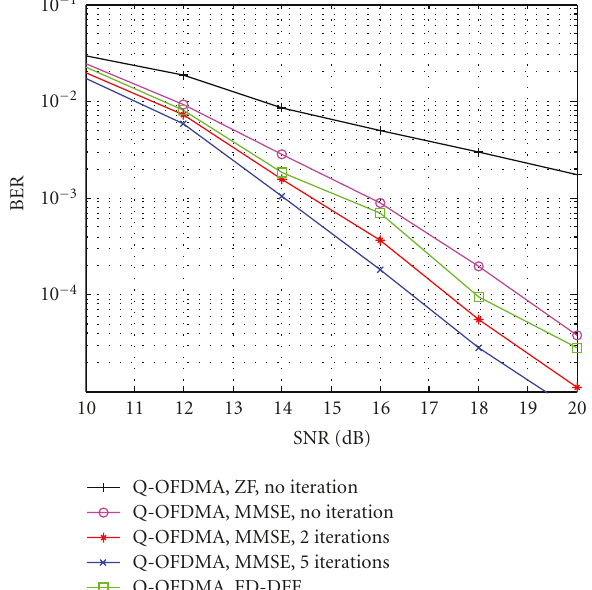
Figure 7: BER performance comparison between Q-OFDMA systems with di ff erent receivers in Wimax channel model, with 64- QAM